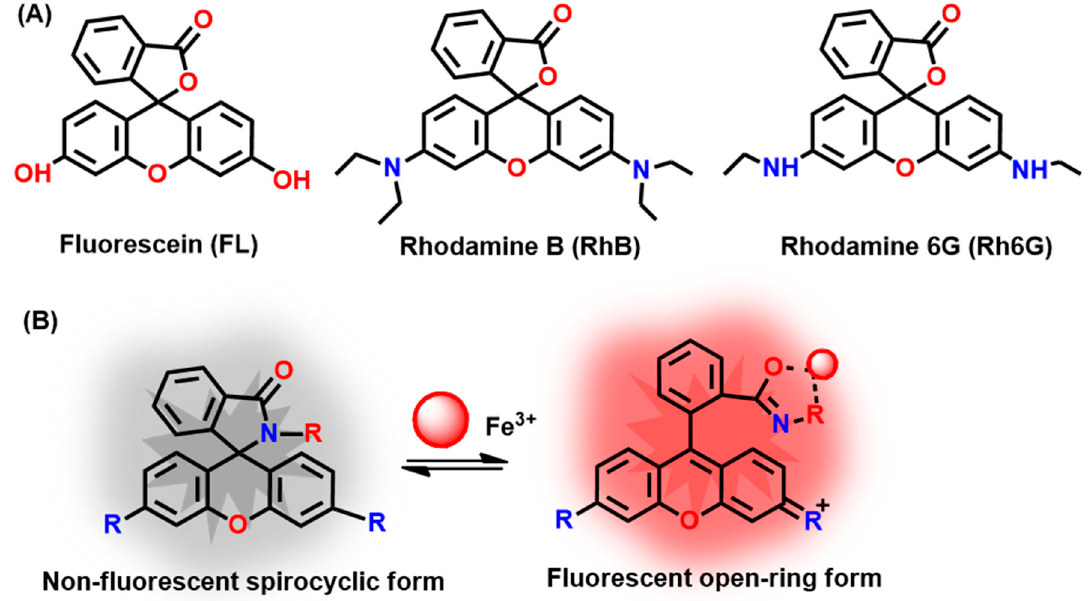
Scheme 2. ( A ) The structure of fluorescein, rhodamine B, and rhodamine 6G; ( B ) The general schematic representation of the mechanism of complexation-induced opening of the spirocyclic ring to give fluorescent enhancement in rhodamine-based fluorescent turn-on probes. Table 1. Fe 3+ -selective rhodamine/fluorescein-based fluorescent turn-on probes. Ex./Em. λ Probes Rh/FL Rh/FL-Y Medium